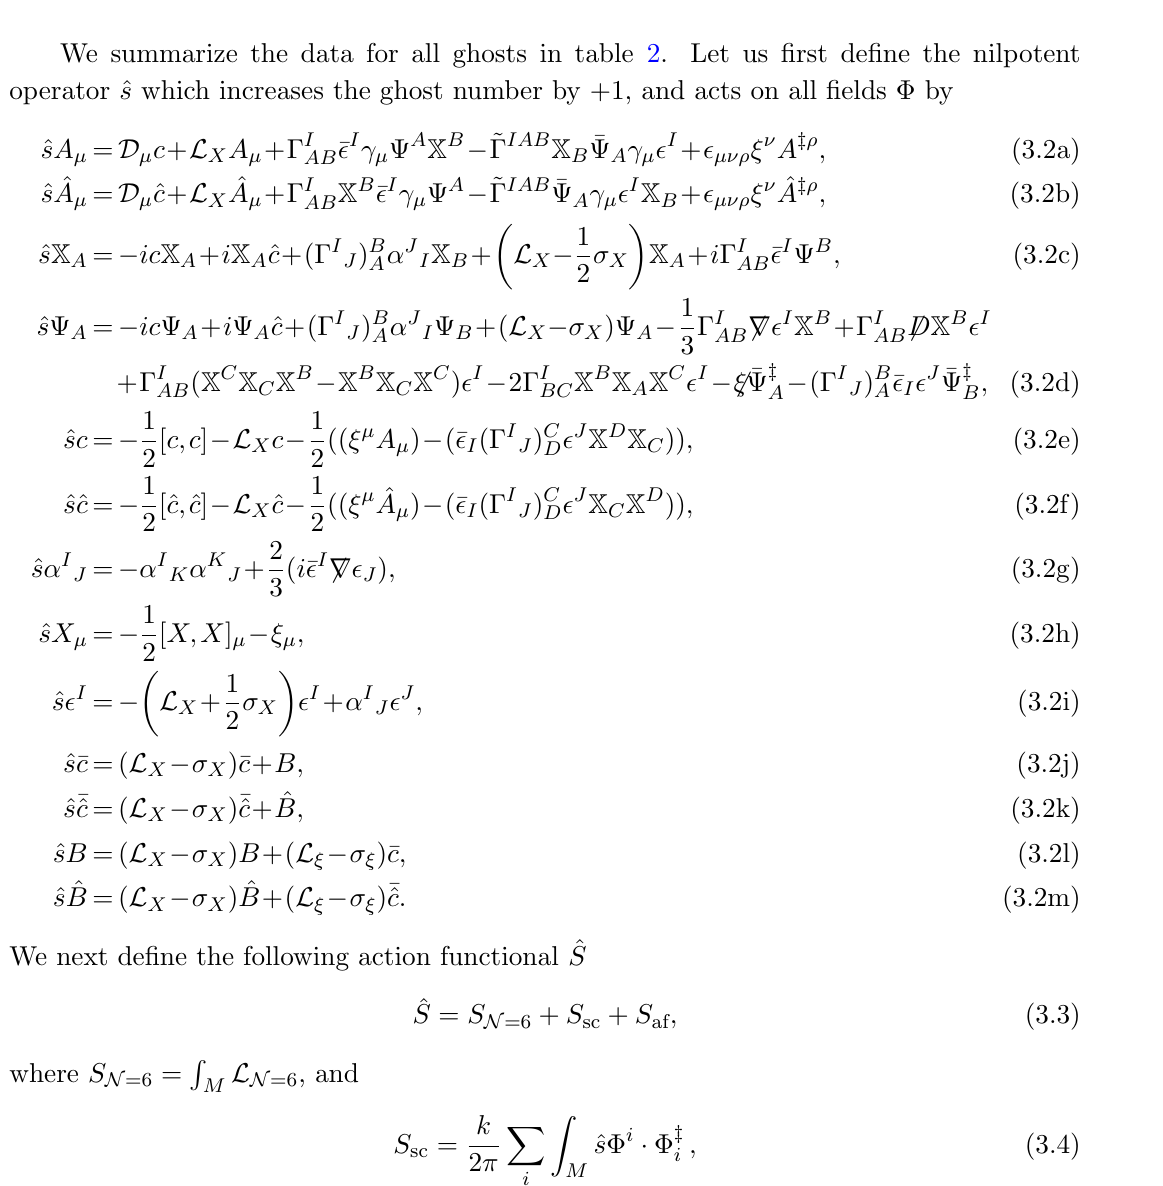
Table 2 . Data for ghosts and gauge-(cid:12)xing